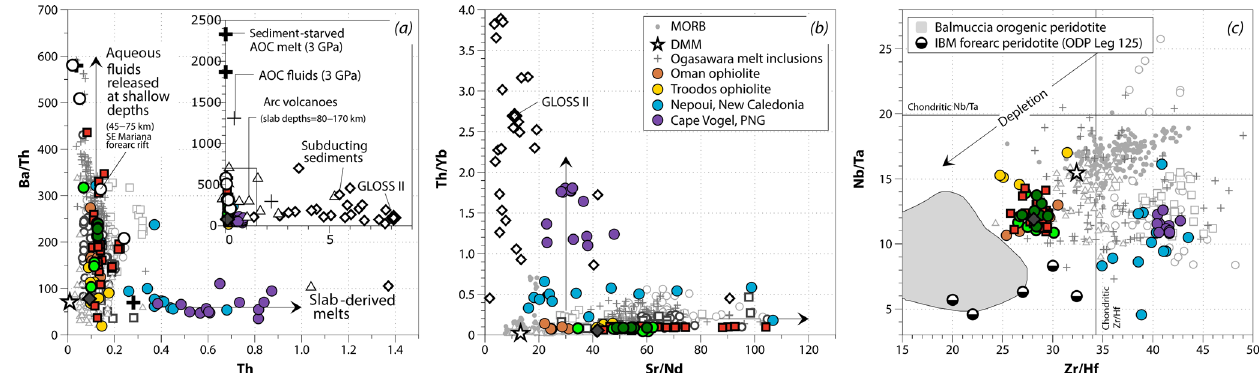
Figure 8. Trace element ratios discriminating the nature of slab-derived components in boninite and boninite-series volcanics. Zambales, Oman and Troodos boninites have distinct LILE and HFSE enrichments compared to Ogasawara, Cape Vogel and Nepoui. Data sources: Ogasawara spinel-hosted boninitic melt inclusions (Umino et al., 2018), altered oceanic crust (AOC) fluids, melts and sediments (Carter et al., 2015), aqueous fluids released at shallow depths (Ribeiro et al., 2015) and subducting sediments and GLOSS II (Plank, 2014). Chondritic bulk Earth Nb / Ta and Zr / Hf ratios are from Münker et al. (2003). DMM and MORB compositions are from Jenner and O’Neill (2012) and Workman and Hart (2005), respectively. Symbols are the same as those in Fig. 6 except those shown in the